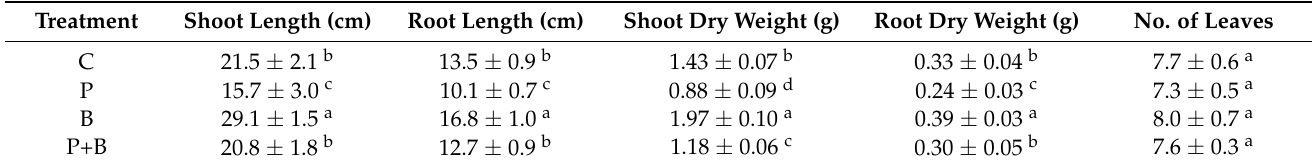
Table 3. Mean growth parameters of tomato plants infected with Rhizoctonia root rot when treated with Bacillus subtilis SR22 at 45 dpi